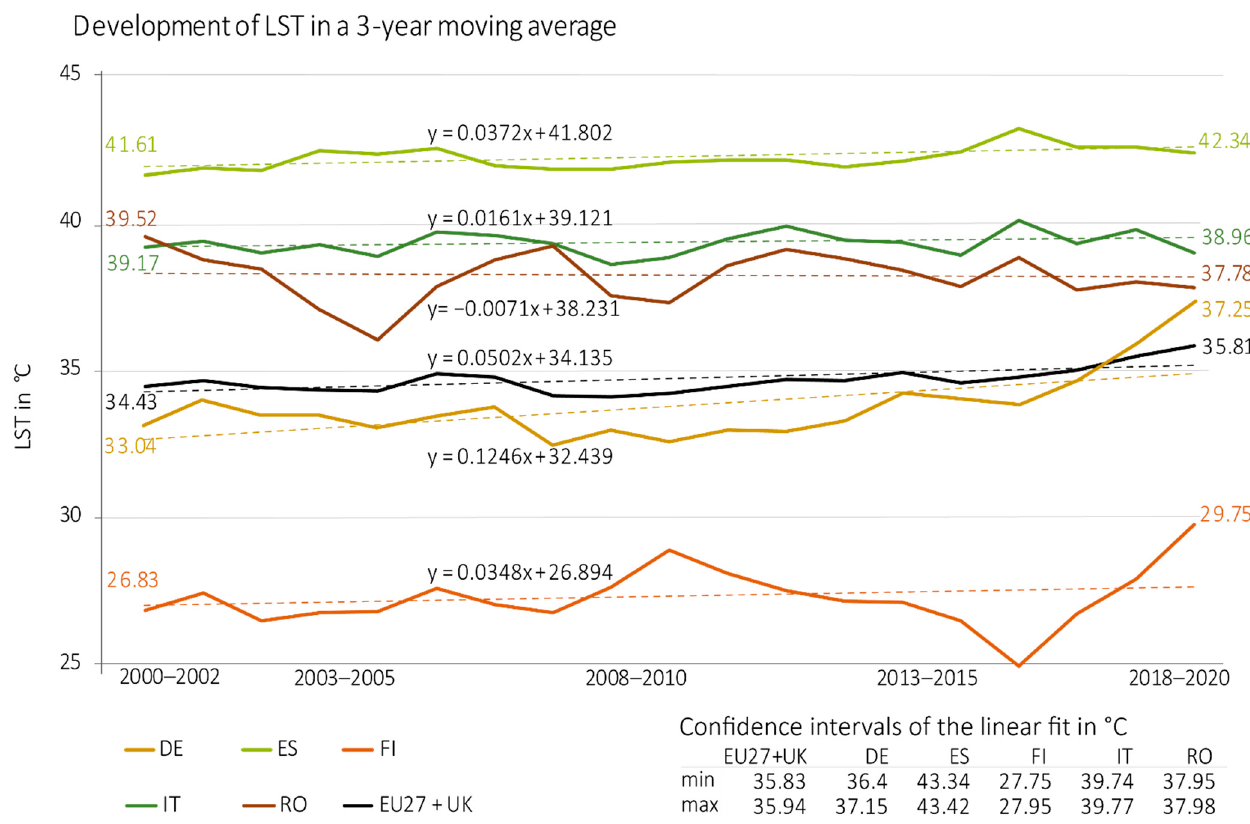
Figure 8. LST change trends at a three-year moving window average during the period from 2000 to 2020. In Germany (DE), Spain (ES), Finland (FI), Italy (IT), and Romania (RO) compared to the member states of the European Union and United Kingdom (EU27 + UK).